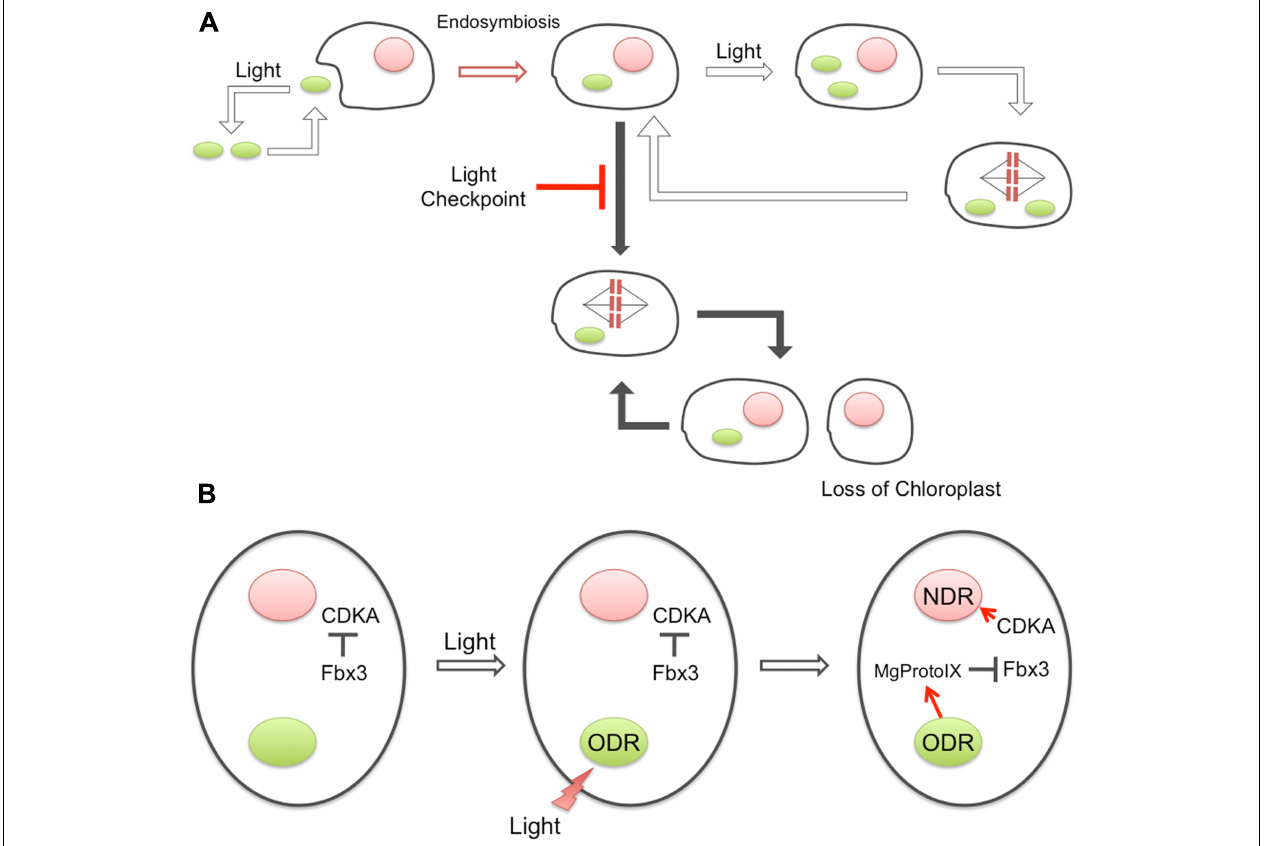
the endosymbiotic association. (B) Architecture of the light checkpoint. Under dark conditions, an F-box component of E3-ubiquitin ligase, Fbx3, recognizes Cyclin1, resulting in ubiquitination and prompt degradation. Cyclin1 is the cyclin that forms a complex with CDKA and activates NDR, and thus, degradation of Cyclin1 prevents NDR in the dark. Light illumination somehow activates ODR and results in the accumulation of Mg-ProtoIX in the cytosol. Interaction of Mg-ProtoIX with Fbx3 prevents the ubiquitination of Cyclin1 and induces the activation of CDKA and